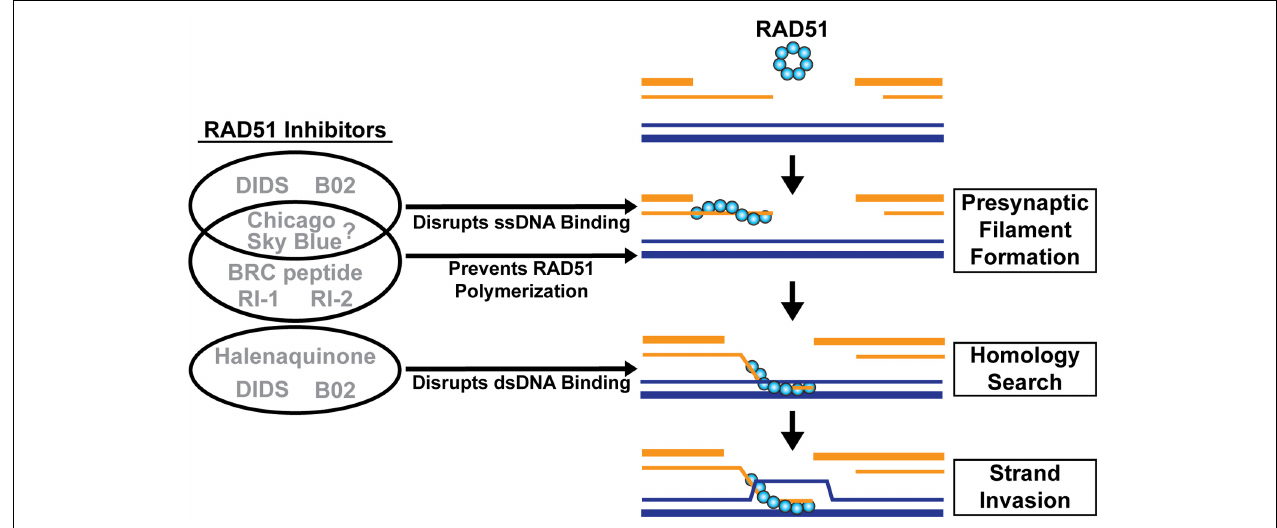
FIGURE 4 | Inhibitors of human RAD51. RAD51 inhibitors can prevent RAD51 from self-associating or from binding ssDNA and/or dsDNA. DIDS and B02 disrupt ssDNA and dsDNA binding. Chicago Sky Blue prevents filament formation but it is unknown if this is through inhibition of ssDNA binding or RAD51 polymerization. RI-1 and RI-2 block RAD51 polymerization binding sites, and the BRC peptide binds filament-dissociated RAD51 monomers, leading to inhibition. Halenaquinone disrupts the dsDNA binding of